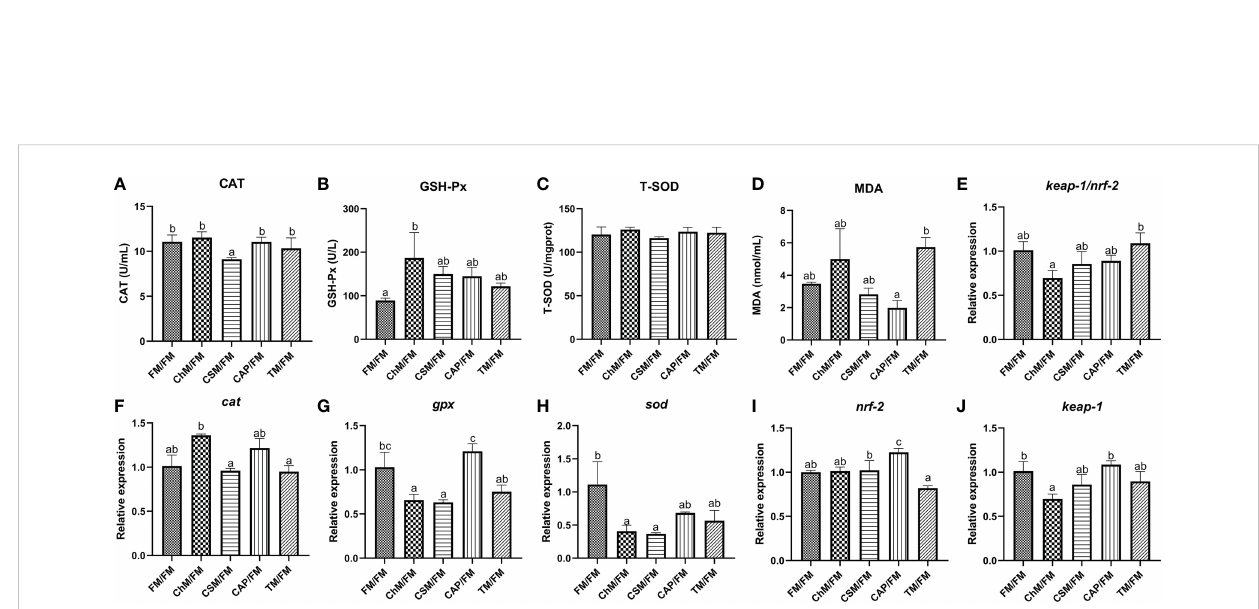
FIGURE 3 The antioxidant enzymes and genes expression of juvenile largemouth bass intestines under an alternate feeding strategy were shown as follows: CAT (A) , GSH-Px (B) , T-SOD (C) , MDA (D) , keap-1 / nrf-2 (E) , cat (F) , gpx (G) , sod (H) , nrf-2 (I) , and keap-1 (J) . Data are expressed as mean (S.E.M). Values on each column with different superscripts typi fi ed statistical differences ( P<0.05 ).